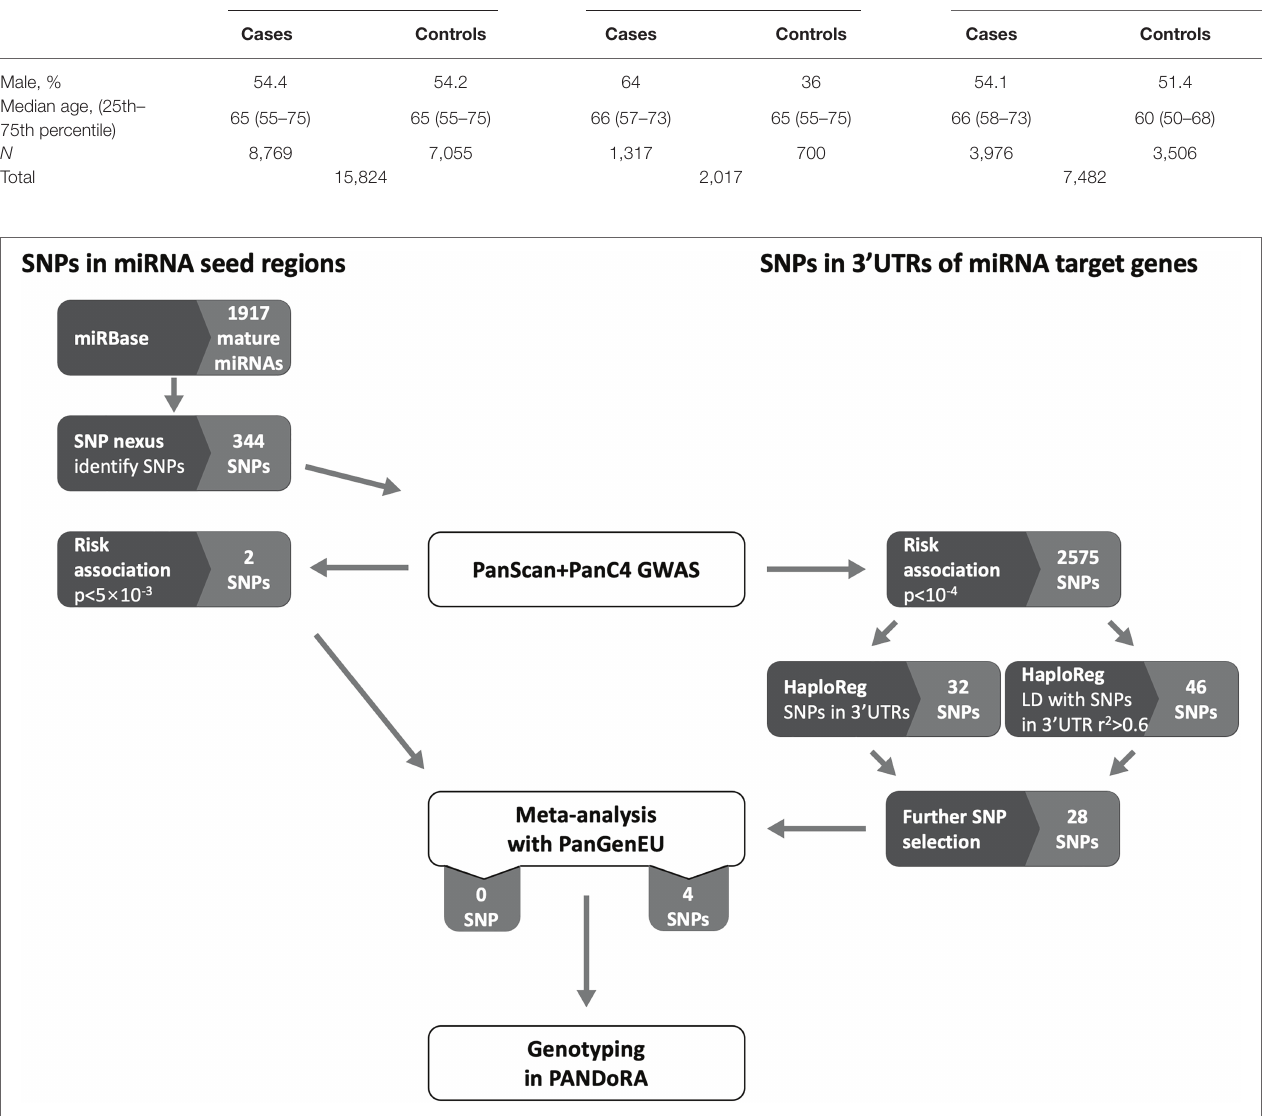
FIGURE 1 | Flow chart of selection of SNPs located in the miRNA seed regions and the 3 prime untranslated regions (3 ' UTRs). Dark gray boxes indicate analytical processes (either database queries, association analysis, or SNP selection). Light gray boxes indicate numbers of miRNAs and SNPs in miRNA seed regions, or numbers of SNPs in 3 ' UTRs of miRNA target genes. White boxes indicate operations in data/sample